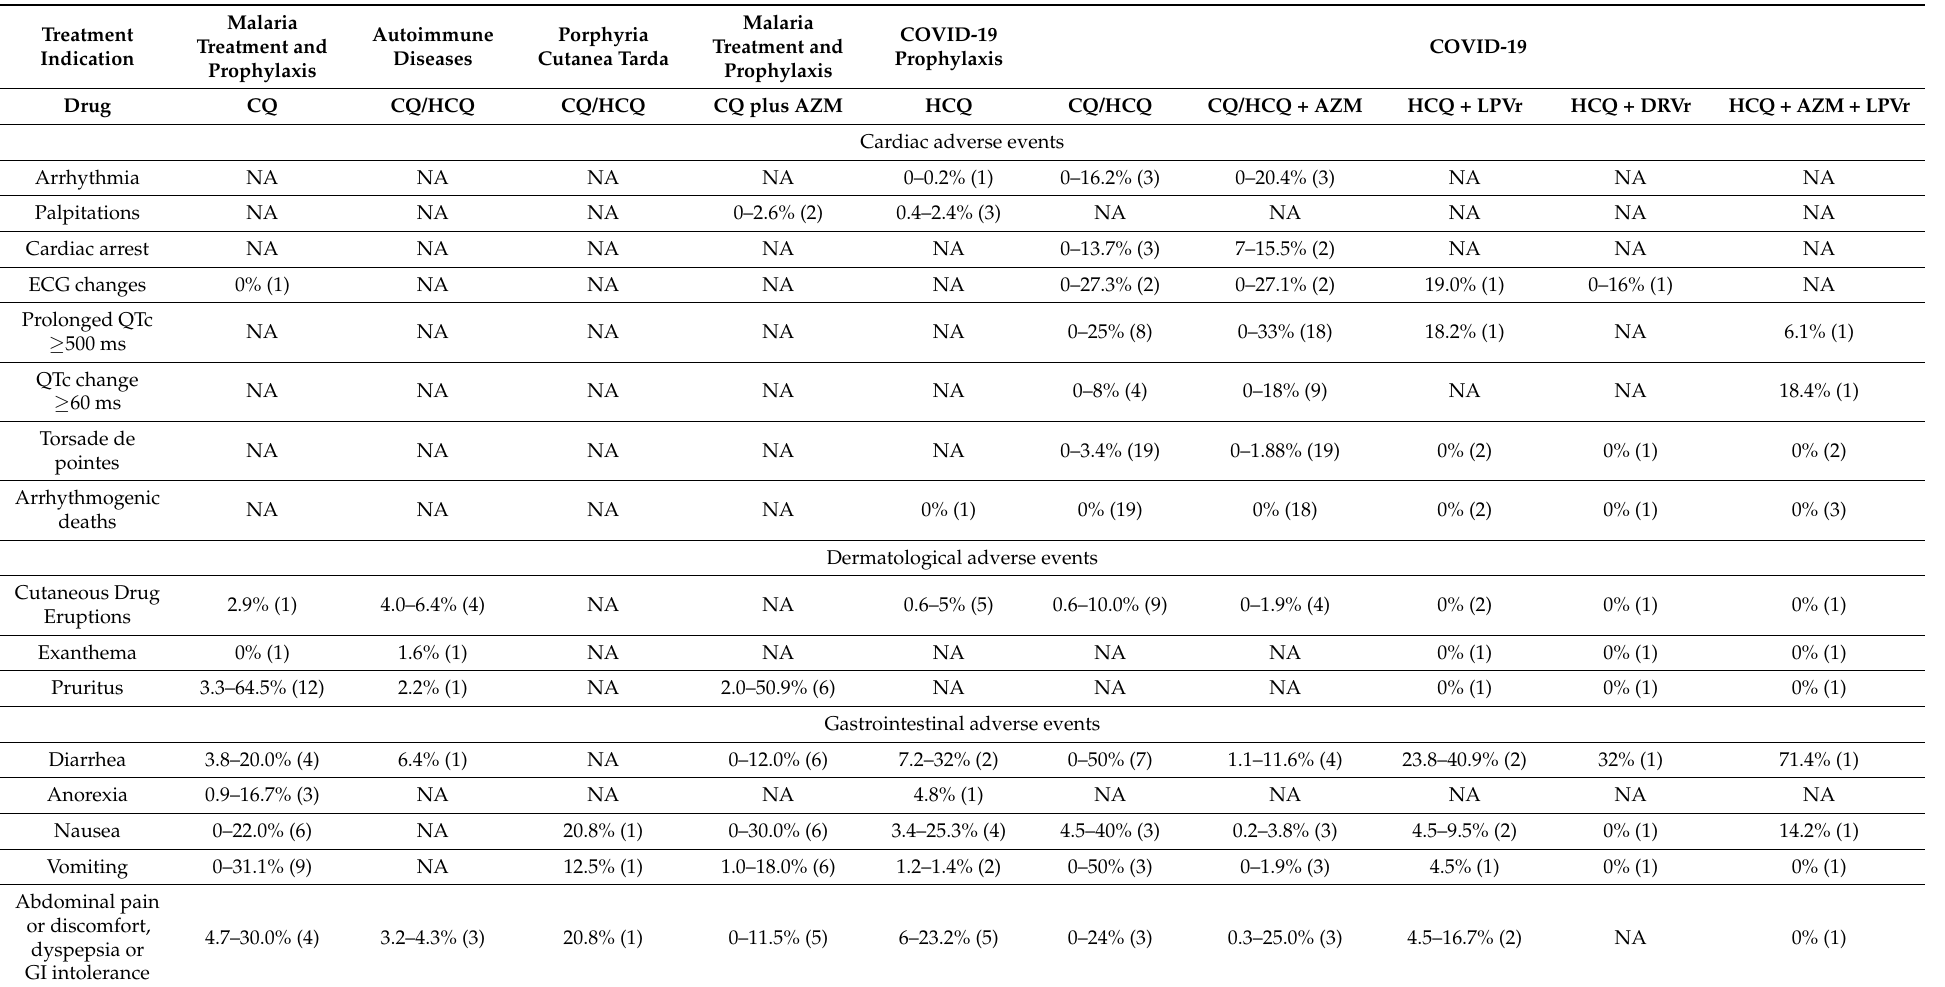
Table 9. Systematic review findings synthesised by the frequency of adverse events reported as a range of